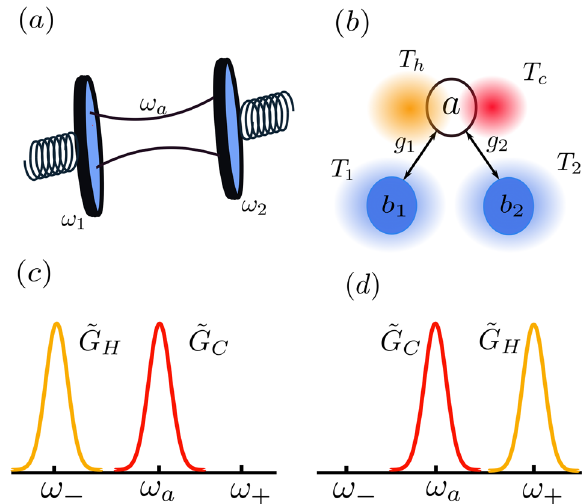
Fig. 1 System description. a Schematic illustration of the optomechanical system being considered in this work. A single optical mode of frequency ω a is coupled to two mechanical resonators of frequencies optomechanical couplings g 1 and g 2 , respectively. b Each mechanical resonator ( b i ) of frequency ω i is in contact with an independent thermal bath at temperature T i , i = 1, 2. In addition, the optical mode is in contact with two independent thermal baths at temperatures T h and T c . c , d Filtered spectra of the optical hot and cold baths given by Eq. (6), for cooling and heating process,